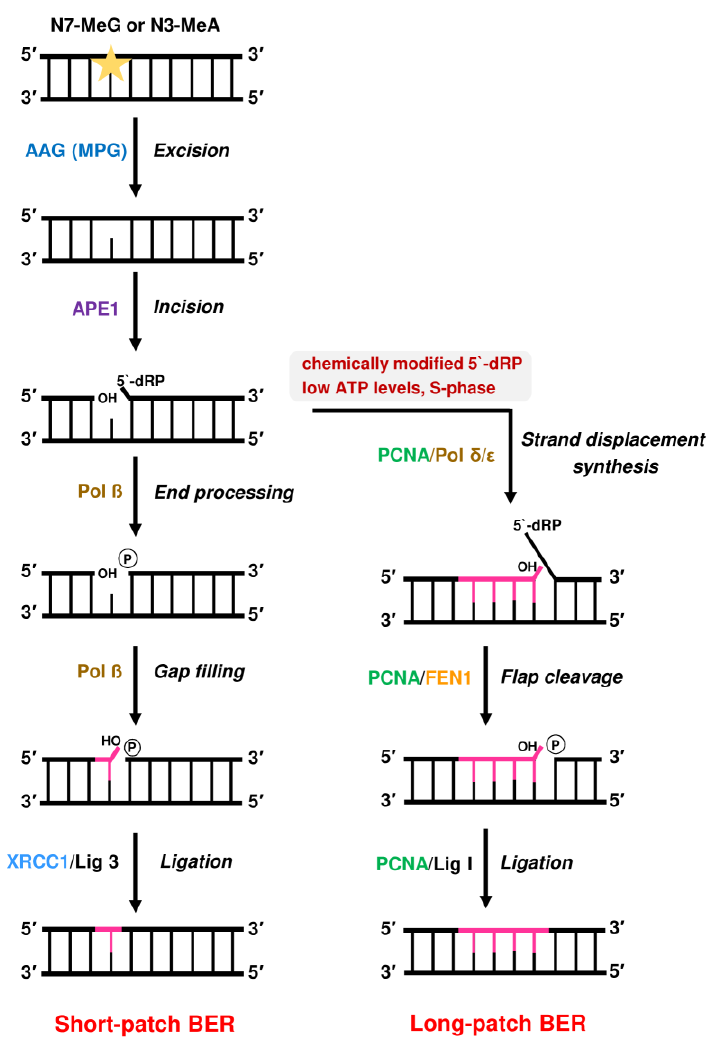
Figure 9. Base excision repair (BER) of DNA alkylation adducts such as N7-MeG or N3-MeA. Overactivation of PARP-1 in response to severe DNA damage results in PARP-1- mediated cell death [185,219]. This is associated with NAD + depletion and rapid ATP loss, which is caused by PARP-1-dependent suppression of glycolysis via PARylation of hexokinase I [220,221]. In line with this notion, genetic or pharmacological abrogation of PARP-1 protected against MMS-induced, AAG-dependent tissue damage and